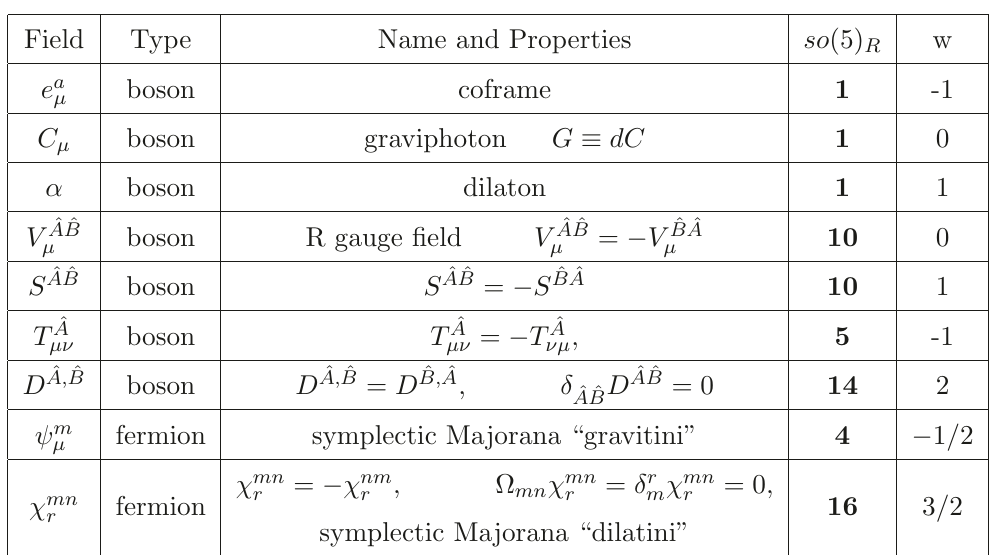
Table 1 . Fields of five-dimensional off-shell